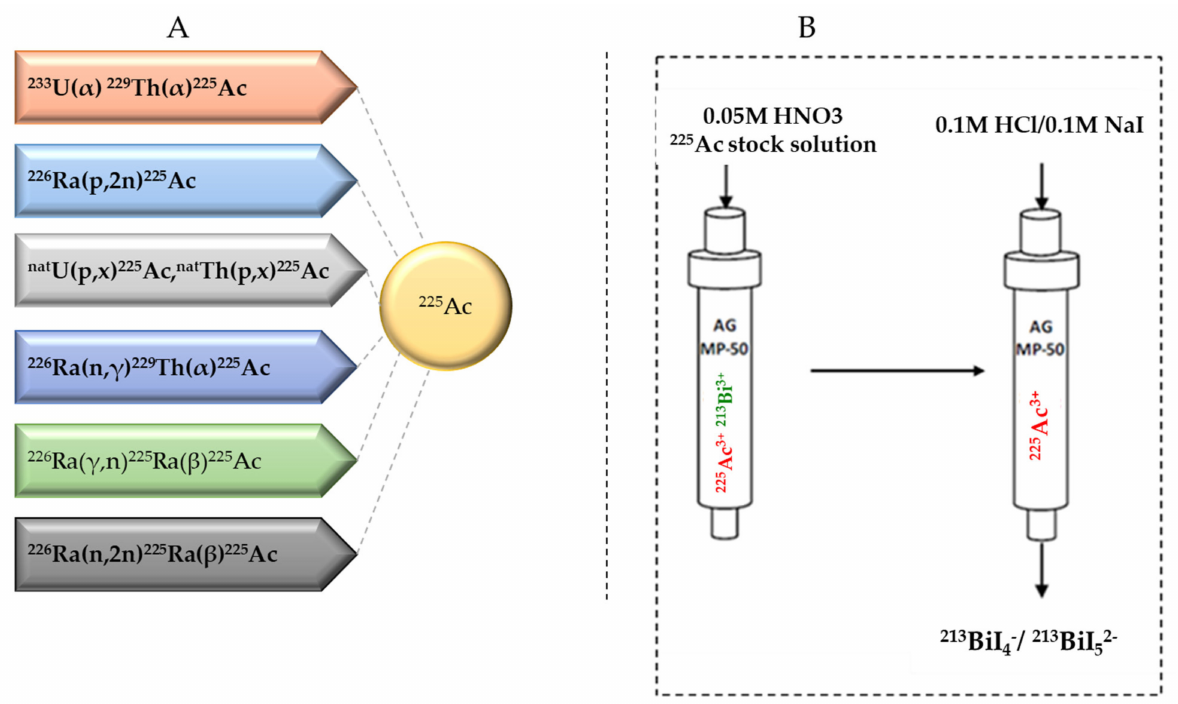
Figure 3. ( A ) Production routes for 225 Ac and ( B ) the 225 Ac/ 213 Bi